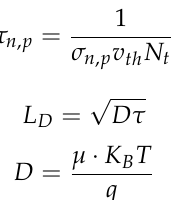
Figure 4. Effect of the absorber layer defect density on the recombination rate with depth from the surface.